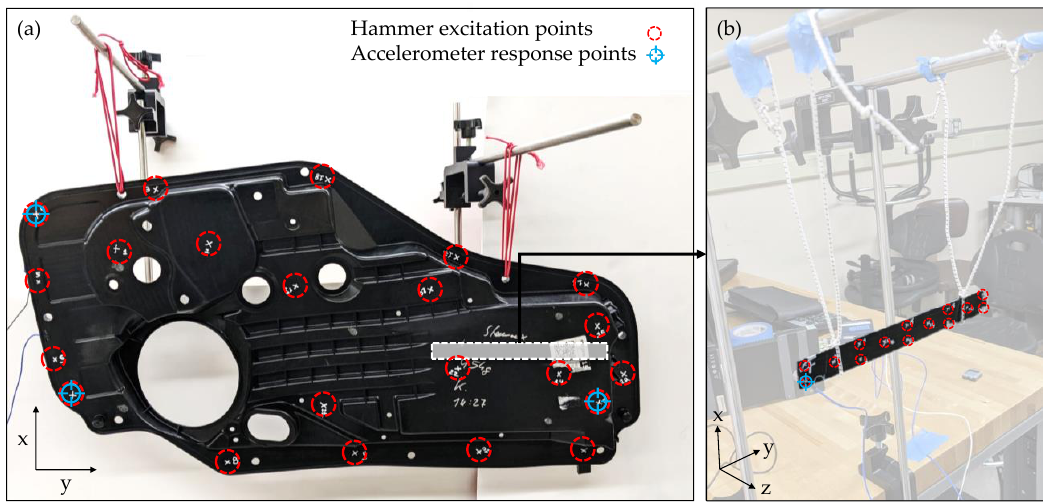
Figure 3. Input and response locations for the hammer tap test. Accelerometers are placed on the backside of parts. ( a ) Door panel. ( b ) Beam extracted from door panel.